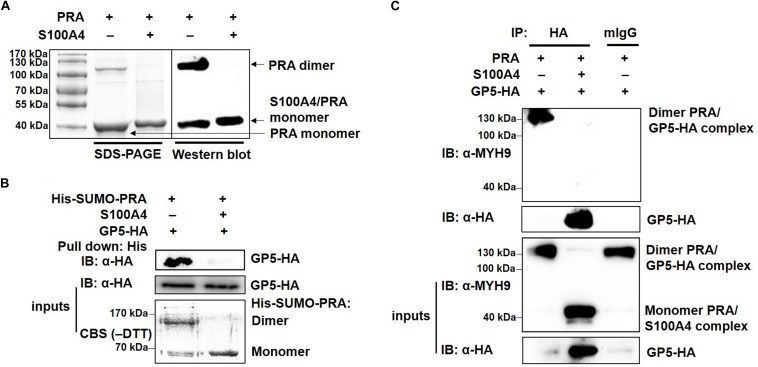
PRRSV GP5 prefers to bind with dimeric PRA to form the interaction. (A) SDS-PAGE and Western blot analyses of S100A4-induced disassembly of PRA filaments. PRA (5 mM) alone or pre-incubation with S100A4 (10 mM, contain 3 mM CaCl2+) at 4°C for 1 h were immunoblotted using anti-MYH9 pAb in non-reducing condition (without DTT). (B) His-pull-down analysis for interaction of GP5 with PRA dimer or monomer. Purified His-SUMO-PRA pretreated with S100A4 or not was bound to anti-His resin and then incubated with lysates from GP5-HA-expressing COS7 cells for pull-down assays. Immunoprecipitated extracts were analyzed by SDS-PAGE and Western blot using anti-HA mAb. CBS: Coomassie blue stain. (C) Co-IP analysis for interaction between GP5 and PRA dimer or monomer. Lysates from COS7 cells expressing GP5-HA were incubated with PRA pretreated with or without S100A4 and then subjected to Co-IP using anti-HA mAb and the immunoprecipitation were immunoblotted using anti-MYH9 pAb and anti-HA mAb in non-reducing condition.